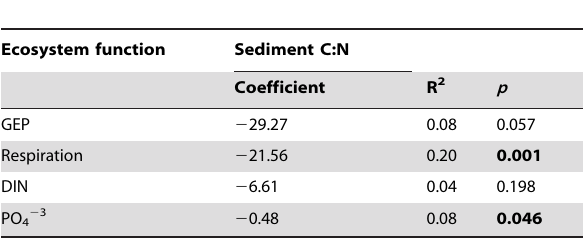
Table 3. Regressions of daily ecosystem flux rates against sediment organic matter quality (C:N; mol:mol).